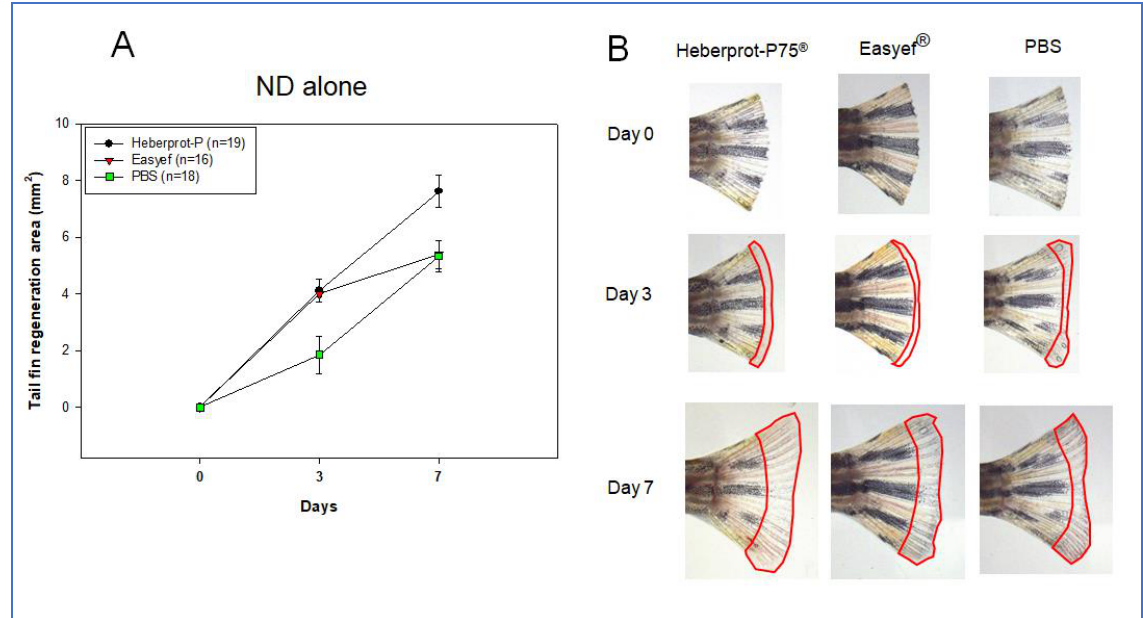
Figure 5. Comparison of tissue regeneration speed ( A ) and morphology in the tail fin ( B ) area under ND consumption during seven days. ND, normal diet.